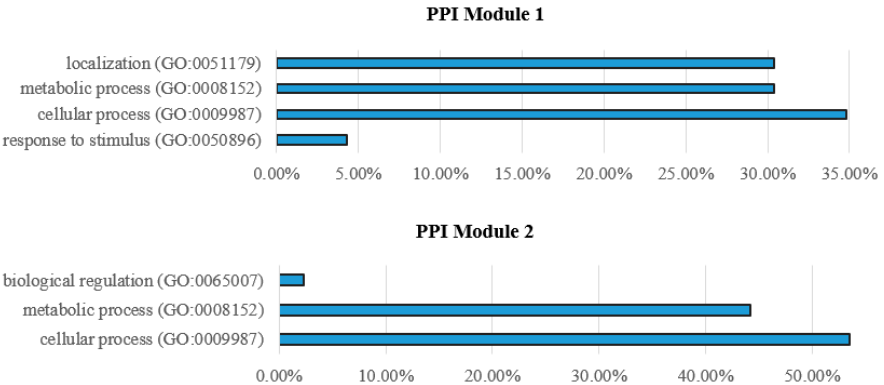
Figure 12. Biological processes of identified PPI network Module 1 (upper graph) and Module 2 (lower graph) in the liver of zebrafish affected by starvation.